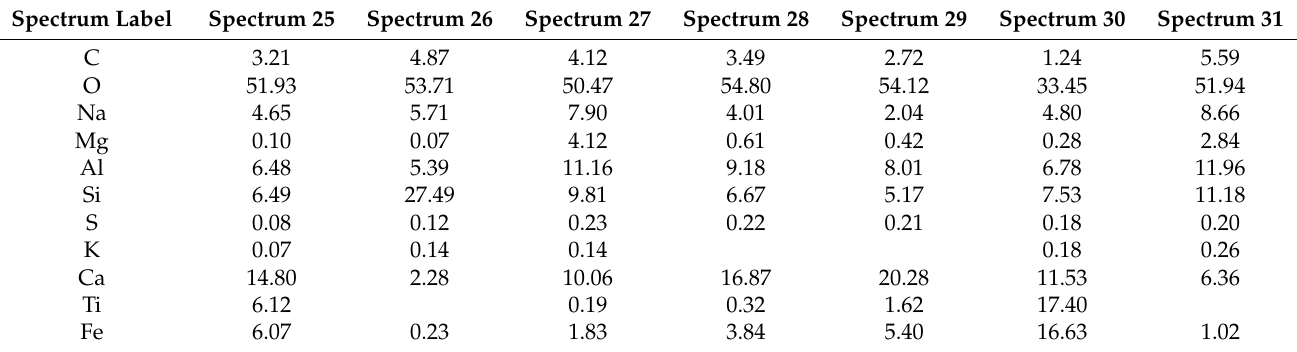
Table 8. Content of elements in analysed points, in